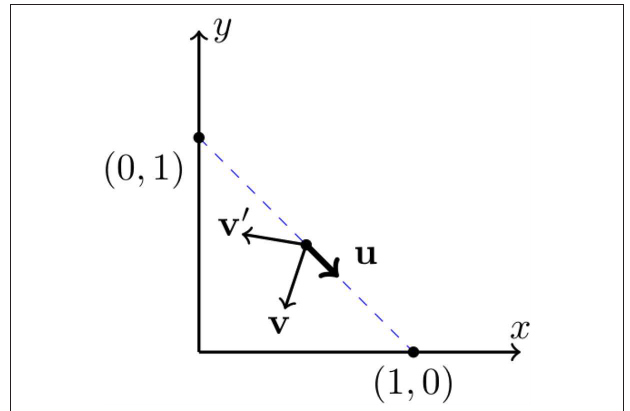
FIGURE 11 | Average values 1 t 16 10 3 vs. time from for a single run of a system reaching consensus = × at A . The convergence time is t conv N 5,000. The inset shows the average number of learning attempts no A , = no B vs. time for the same single run.